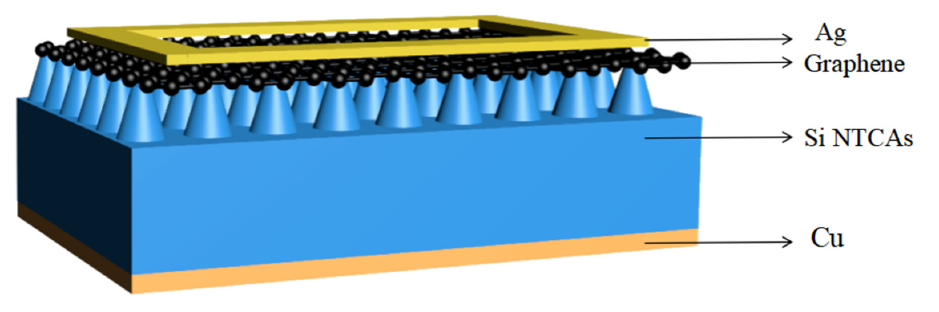
Figure 1. Schematic illustration of the graphene/Si NTCAs heterojunction photodetector.